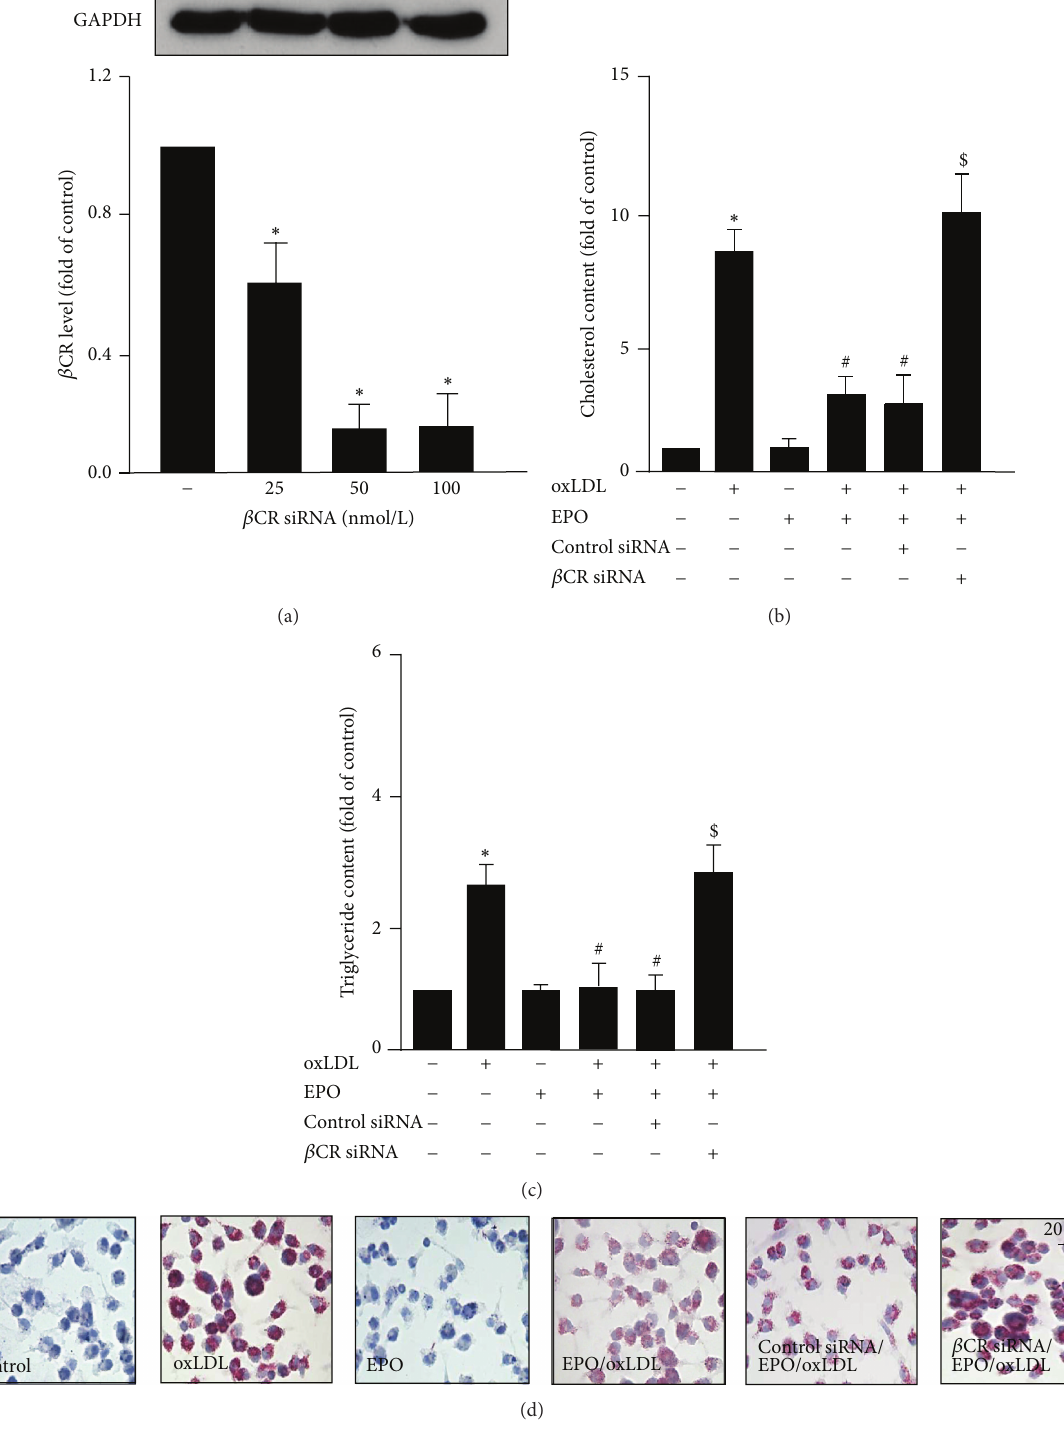
Figure 5: Knockdown of 𝛽 CR expression ablates the EPO-mediated protection of oxLDL-induced lipid accumulation in macrophages. (a) Bone-marrow-derived macrophages were transfected with indicated concentrations of 𝛽 CR siRNA (25, 50, and 100nmole/L) for 24 h. Protein level of 𝛽 CR was examined by western blot analysis. Cells were transfected with control siRNA (50nmole/L) or 𝛽 CR siRNA (50nmole/L) for 24 h and then treated with EPO (5U/mL) for 12h, followed by oxLDL (50 𝜇 g/mL) for additional 18 h. ((b) and (c)) The intracellular levels of cholesterol and triglyceride were extracted by hexane/isopropanol (3/2, v/v) and analyzed by colorimetric assay kits or (d) subjected to oil-red O staining. Cellular nuclei were stained with hematoxylin. Data is mean ± SEM from 5 independent experiments. ∗ 𝑃 < 0.05 versus vehicle-treated group, # 𝑃 < 0.05 versus oxLDL alone-treated group, $ 𝑃 < 0.05 versus oxLDL+EPO-treated